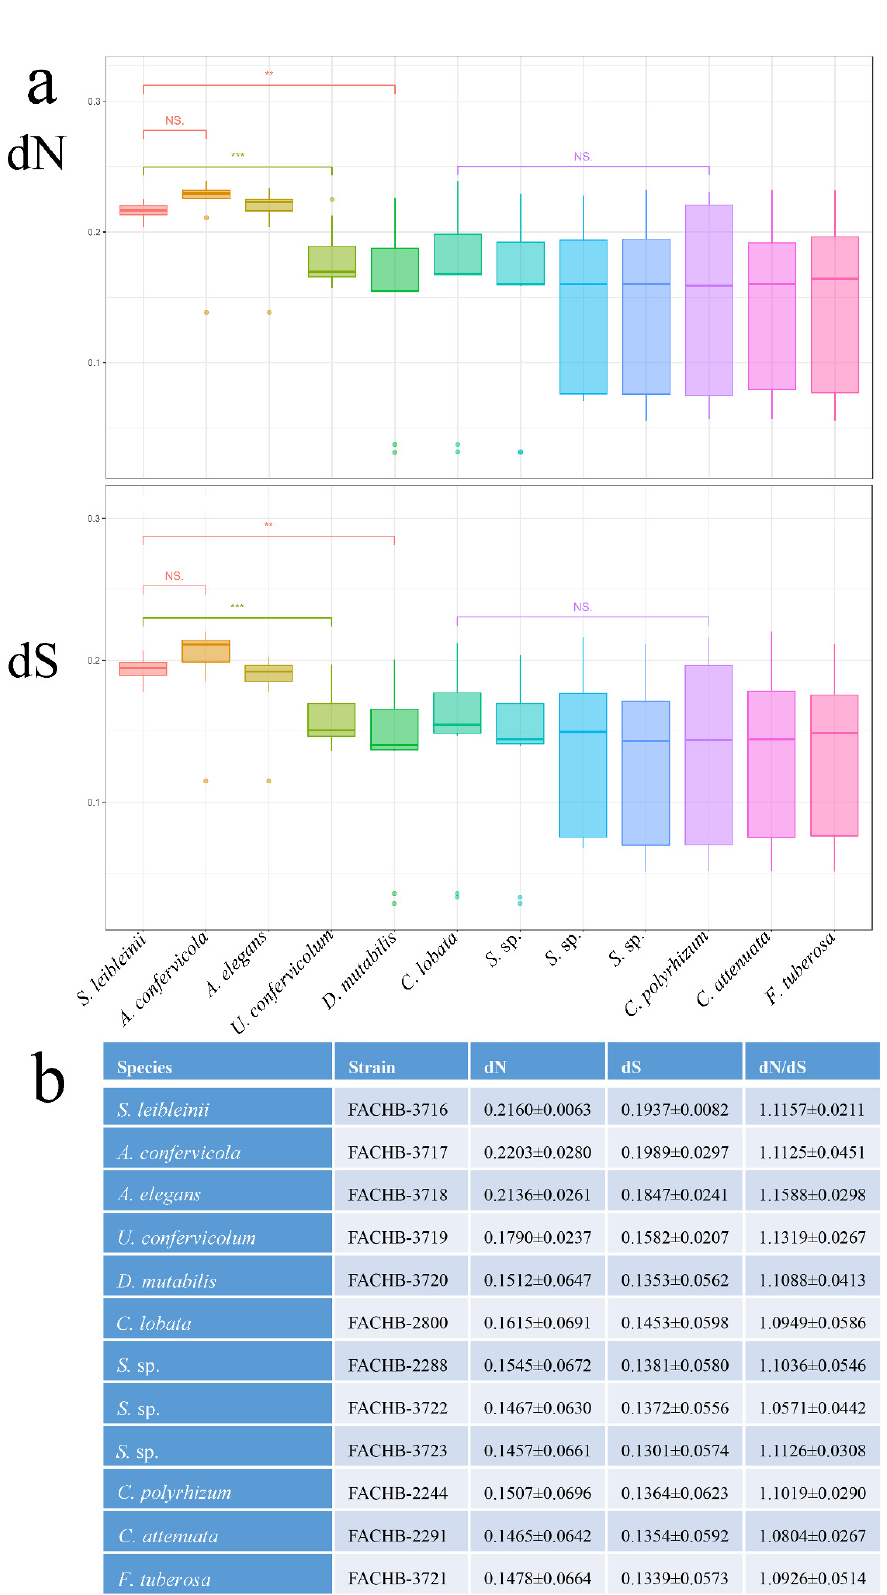
Figure 5. ( a ). Boxplots showing non-synonymous (dN) and synonymous (dS) substitutions of the Chaetophorales. ** 0.001 < p < 0.01, *** p < 0.001, NS., non-significant. ( b ) The average value and standard deviation of dN, dS and dN/dS for each species.